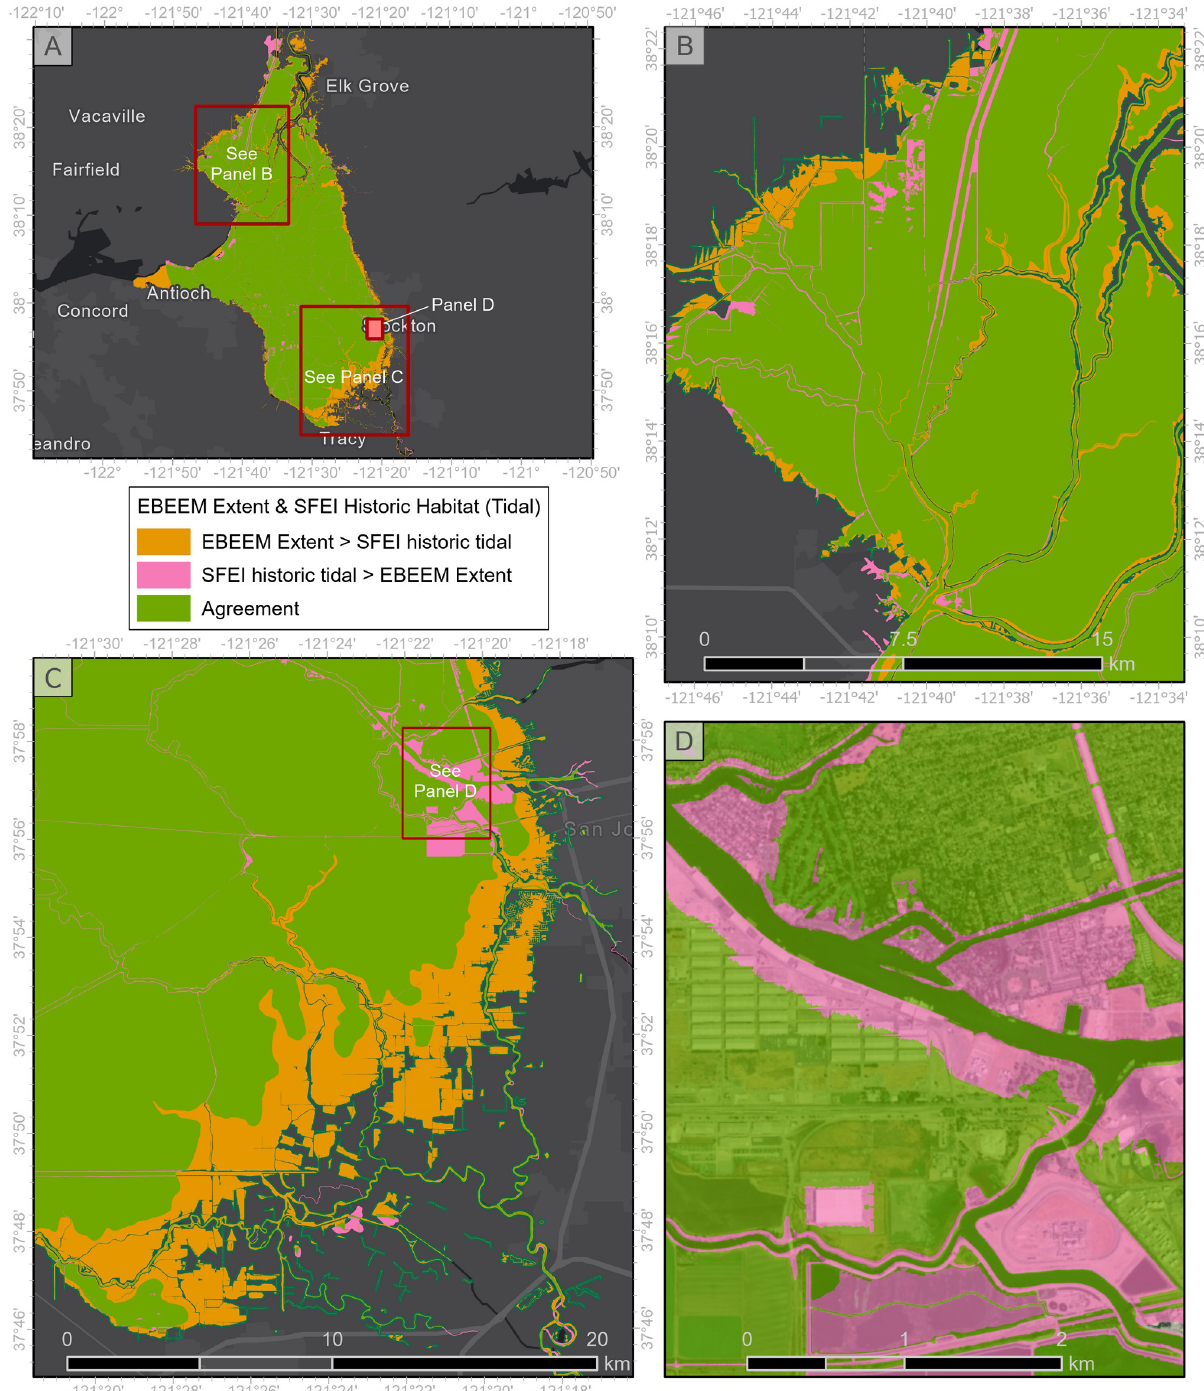
Fig 5. Comparison of historical estuarine footprint in the Sacramento-San Joaquin delta. The comparison illustrates agreement and disagreement between the historical footprint from EBEEM mapping (PMEP) compared to historical ecology mapping by the San Francisco Estuary Institute [17]: the entire extent of the delta (A), a magnified region in the north delta (B), a region in the south delta (C), and an urban area in the central delta with a large amount of disagreement between mapping efforts (D).